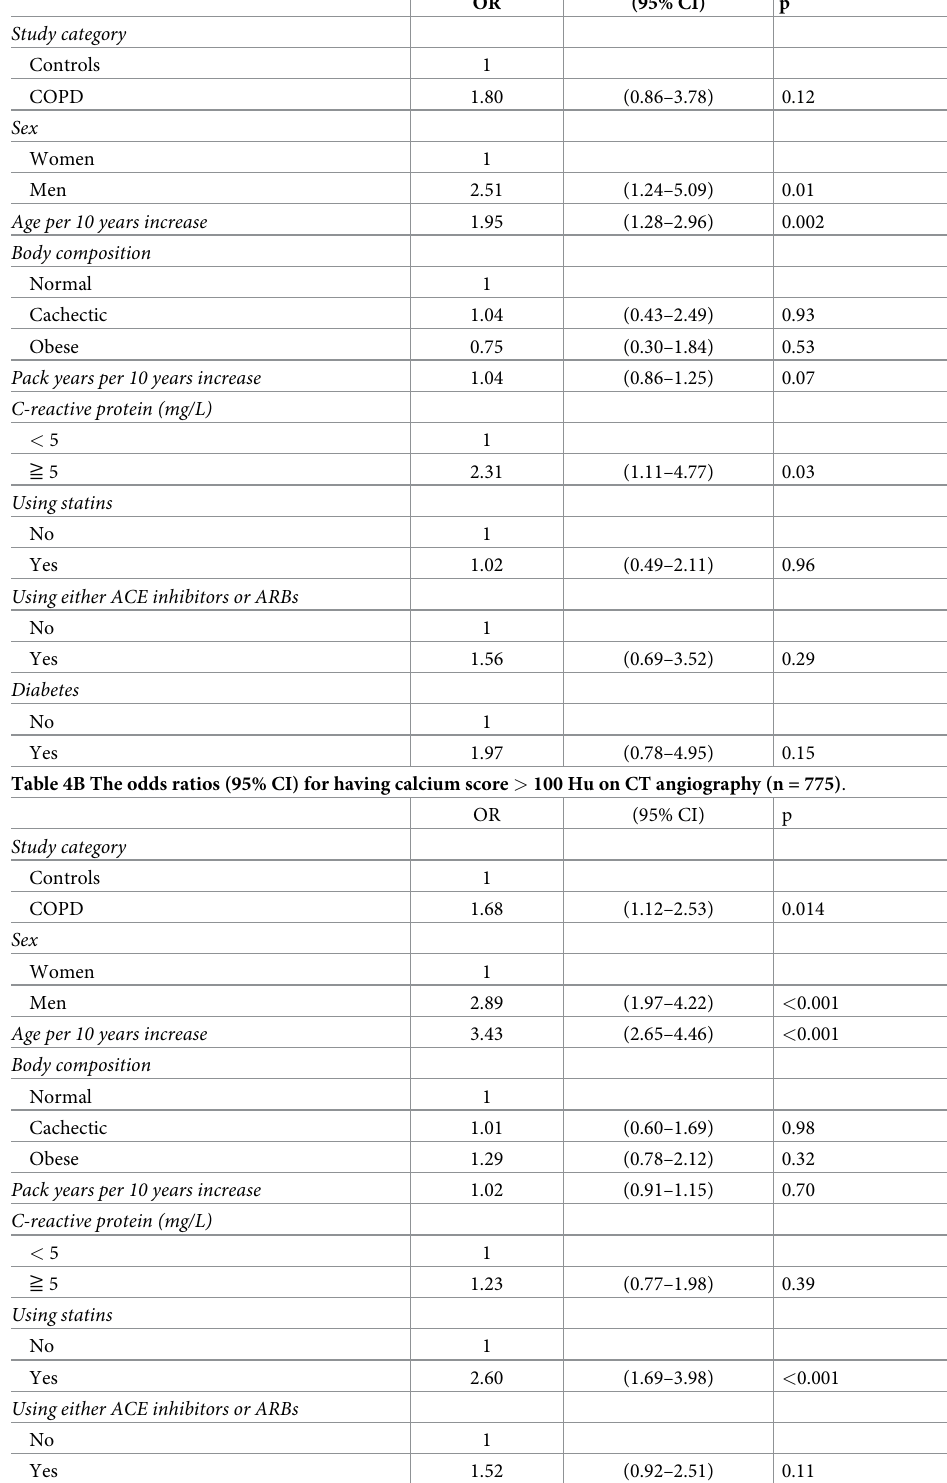
Table 4A. The odds ratios (95% CI) for having significant coronary stenosis on CT angiography (n = 574).